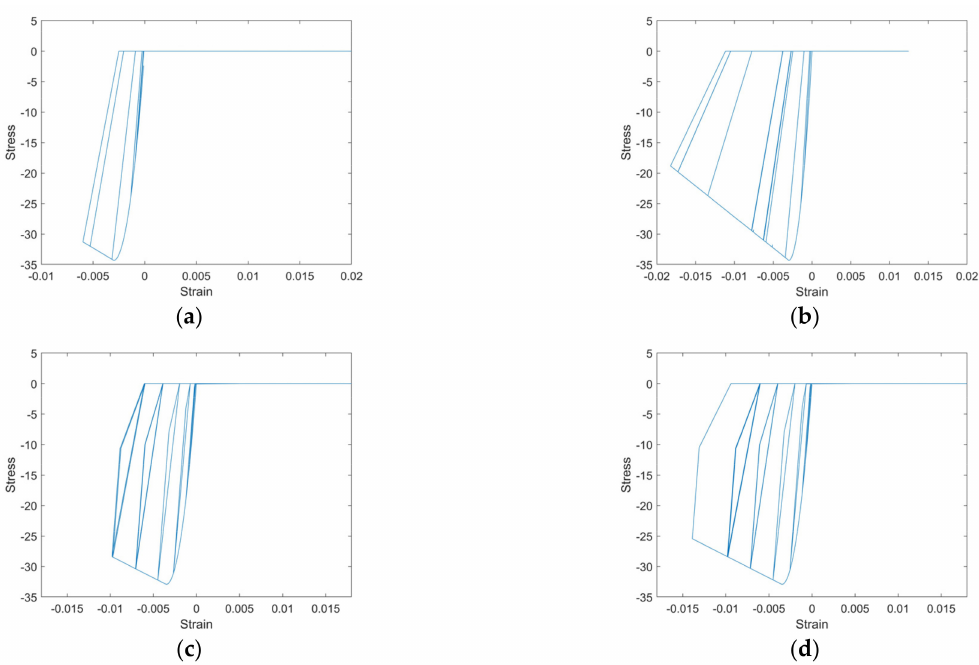
Figure 10. Stress-strain diagrams of concrete: ( a ) upper part of the beam end of the A2 specimen; ( b ) lower part of the beam end of the A2 specimen; ( c ) upper part of the beam end of the B2 specimen; ( d ) lower part of the beam end of the B2